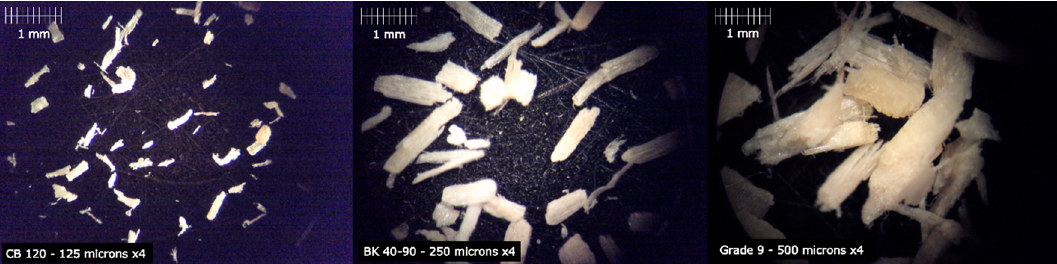
Figure 1. From left to right, micrographs of CB 120 retained on the sieve of 125 microns, BK 40-90 retained on the sieve of 250 microns and Grade 9 retained on the sieve of 500 microns.